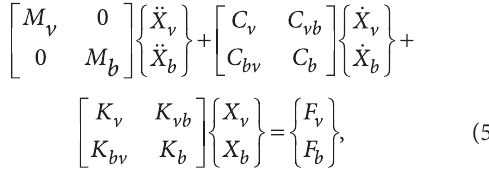
Fig. 2. The width of the bridge is 9.3 m with double-tracks.